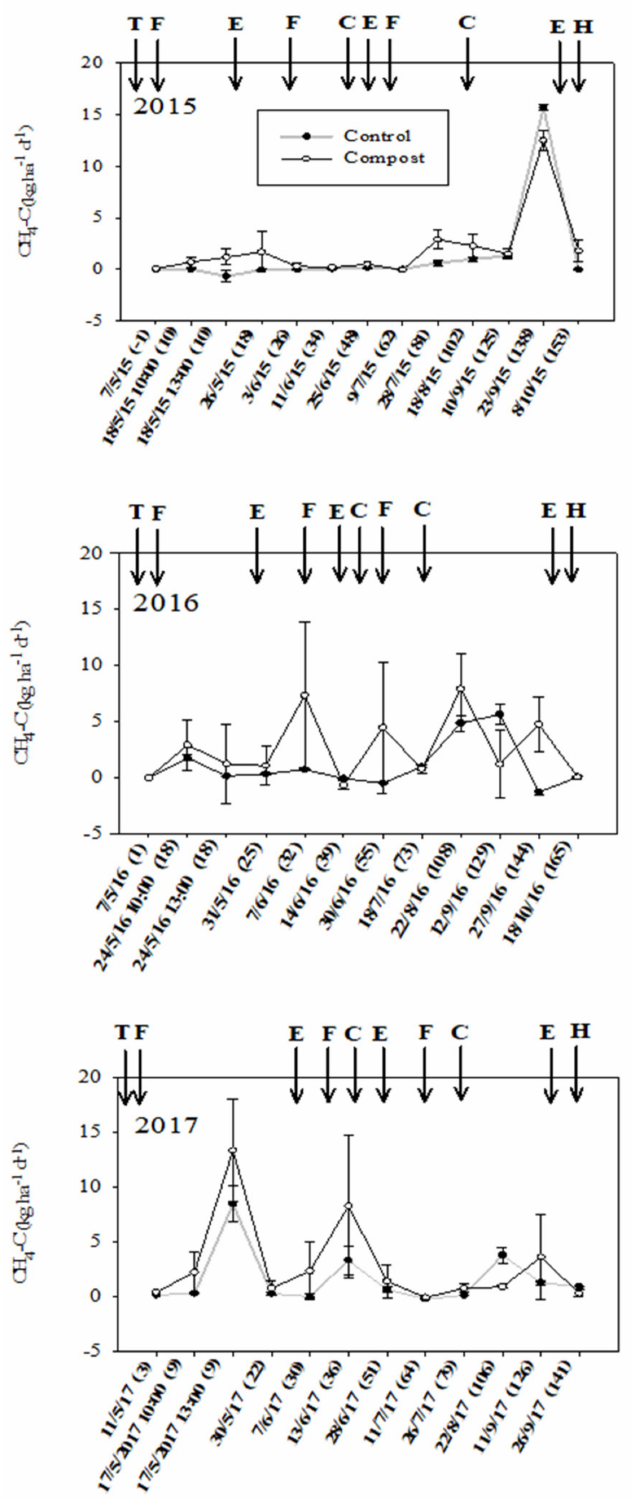
Figure 2. Effect of different management systems on CH 4 emission throughout the rice growing cycle. The error bars represent the standard error of the mean ( n = 3). T: Tillage and fertilizer, C: Cover fertilizer, F: Flood, E: Emptying of terraces, H: Harvest. The numbers in parentheses on the x -axis indicate days after sowing